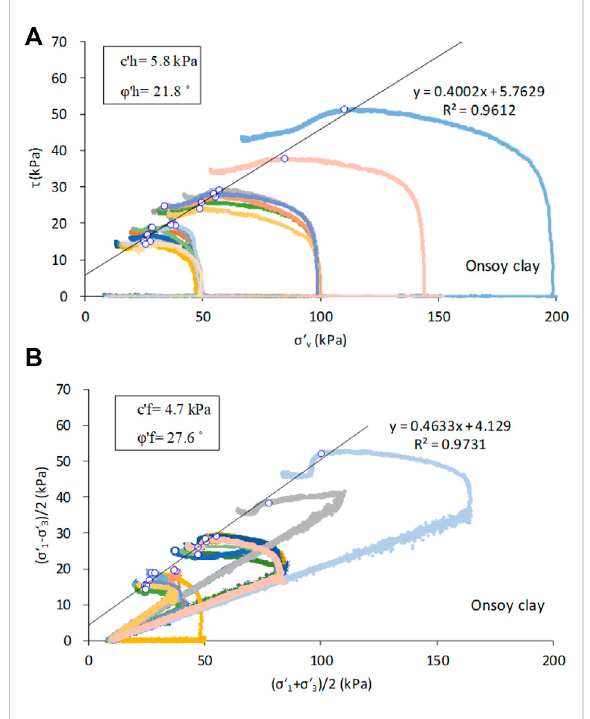
FIGURE 13 Stress path and failure envelope-based effective stresses for Onsoy clay: (A) horizontal plane, (B) failure